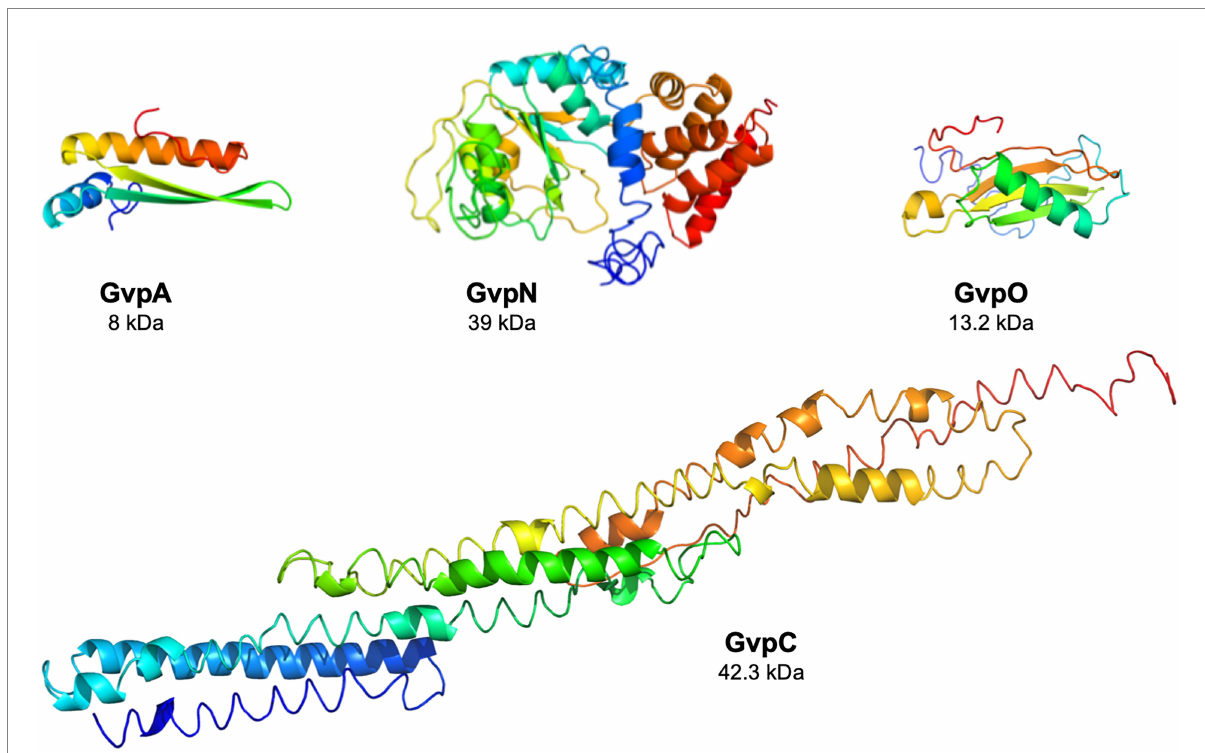
FIGURE 1 Structural models of the four Gvp proteins. The structural model of GvpA has been obtained in silico (Strunk et al., 2011), and the structural models of the other proteins were calculated by the I-Tasser server (Zhang, 2008; Roy et al., 2010; Yang et al.,